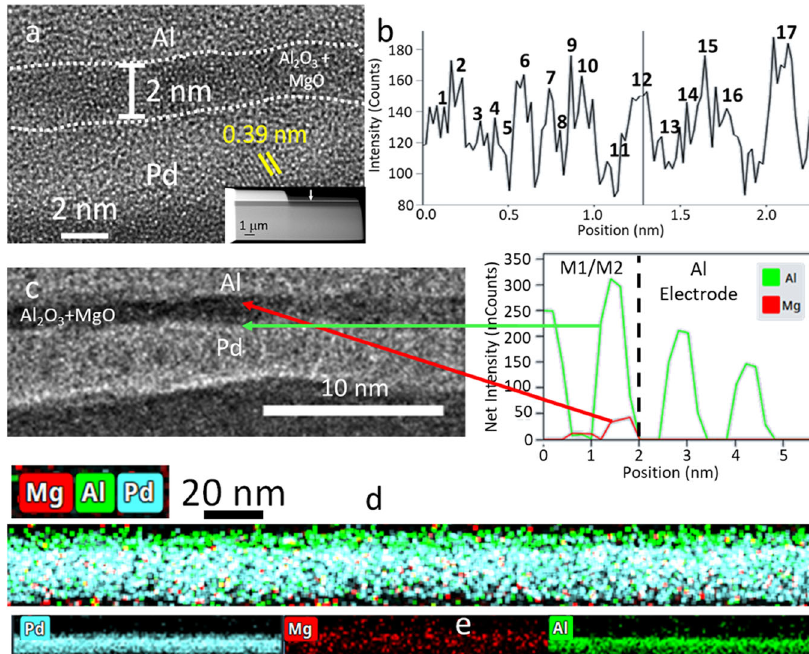
Fig. 4 Electron microscopy analysis of memristor microstructure. Transmission Electron Microscopy (TEM) analysis of the memristors architecture for case d in Fig. 3. The images represent: a the actual memristor architecture in High Resolution (HRTEM) mode. The inset in a is the focus ion beam lamella (or the TEM Sample) showing the memristors highlighted with an arrow, b the pro fi le for the 17 atomic layer deposition (ALD) deposited Al 2 O 3 and MgO atomic layers using HRTEM mode where the peaks are attributed to the atomic layers while the valleys, the interstitial space between the neighboring layers. Each of the 17 layers is identi fi ed by a number, c the zoom-out view of the memristor in bright fi eld mode, d the similar area to c under energy dispersive X-ray spectroscopy (EDS) mode showing the presence of the main memristor elements of Mg, Al, and Pd, as well as e independent EDS maps for these key